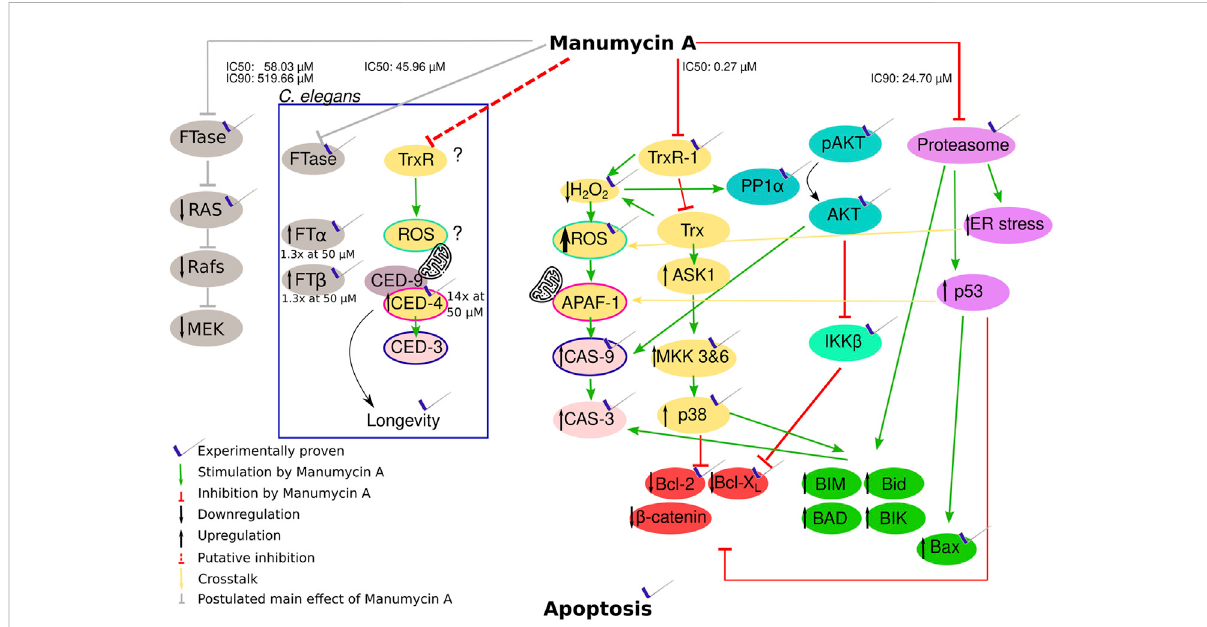
Hypothesis of how Manumycin A acts with the proven or probable in fl uence on apoptotic metabolic pathways. Yellow and pale red part: Manumycin A inhibits the TrxR-1 enzyme, a major player in the mammalian redox system. The inhibition decreases the intracellular H 2 O 2 and increases theintracellular reactiveoxygen species(ROS). Thisleadsto anactivationofcaspase-9 and caspase-3 triggering apoptosis.Theincreasing ROS levels lead to the oxidation of Trx that cannot be reduced by TrxR1 due to its inhibition. The oxidized Trx detaches from ASK1, promoting theproapoptoticproteinsanddownregulatingtheantiapoptoticproteins via severalintermediatesteps.Turquoisepart:ThelowerH 2 O 2 levelscause a reduced inhibition of PP1 α , resulting in a dephosphorylation of Akt that no longer can exert its anti-apoptotic activity. Caspase 9 is signi fi cantly less inhibited. Light green part: The β -subunit of the I κ B kinase complex is inhibited, whereby the NF- κ B inhibitor α is no longer phosphorylated and the transcription factors of the propapoptotic proteins Bcl-2 and Bcl-X L are less functional. Pink part: The proteasome is inhibited by Manumycin A, resulting in less degradation of proapoptotic proteins. An increased ER stress additionally promotes an increase in ROS. Green part: Proapoptotic proteinsin fl uencedbythedifferentpathways.Redpart:Antiapoptoticproteinsin fl